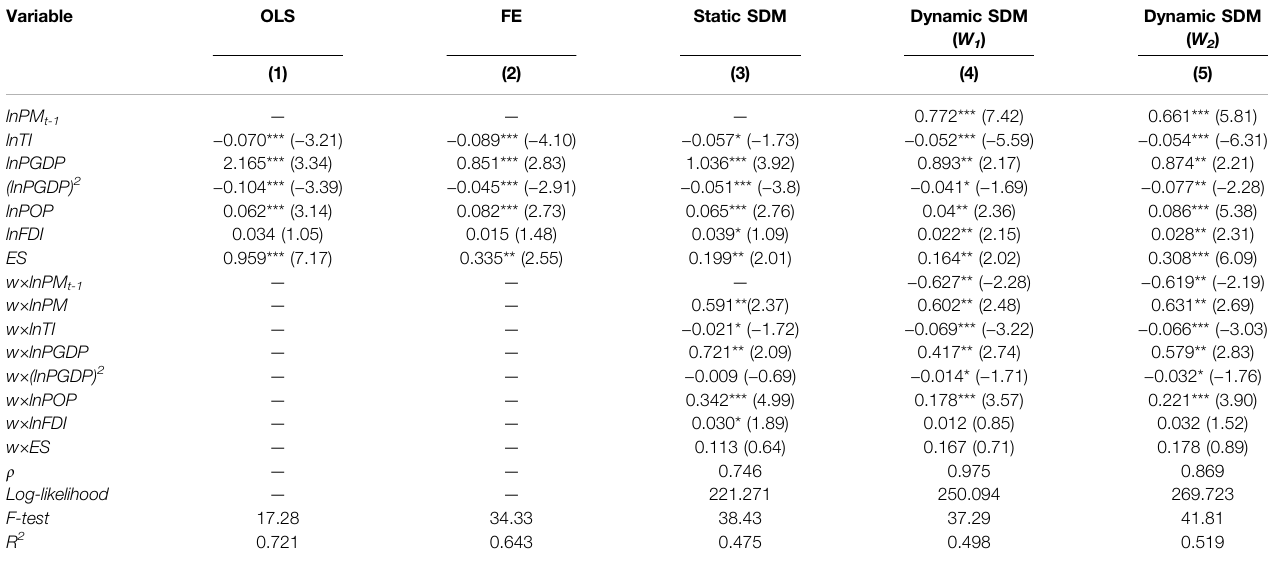
TABLE 4 | Empirical results of low-carbon technology innovation and haze pollution. Variable